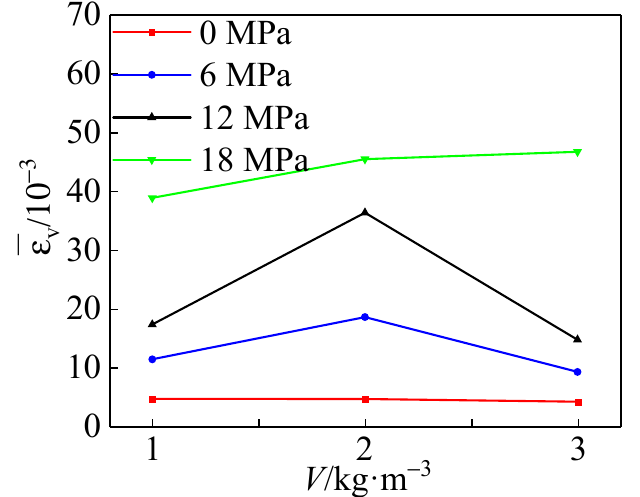
Figure 21. Relationship between the amount of polypropylene fibers addition and the average peak strain.